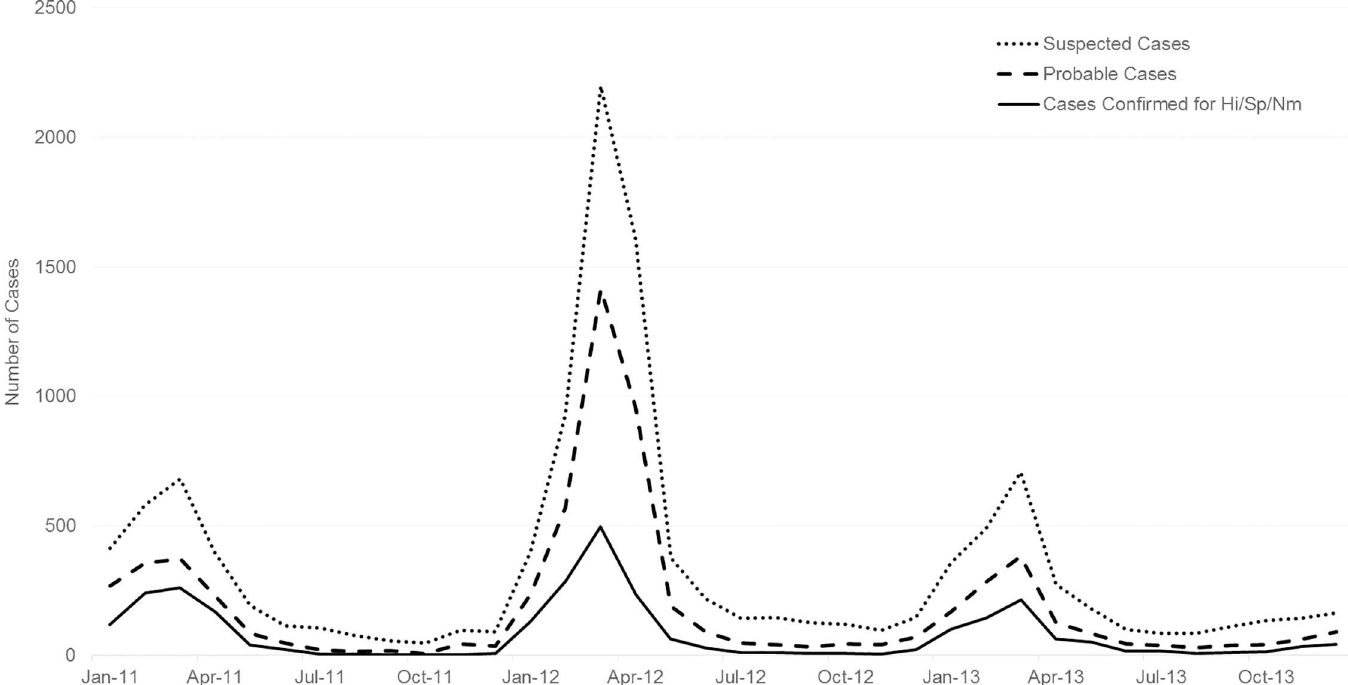
Fig 2. Epidemic curve of all suspected, probable, and confirmed meningitis cases by month, Burkina Faso, 2011–2013.